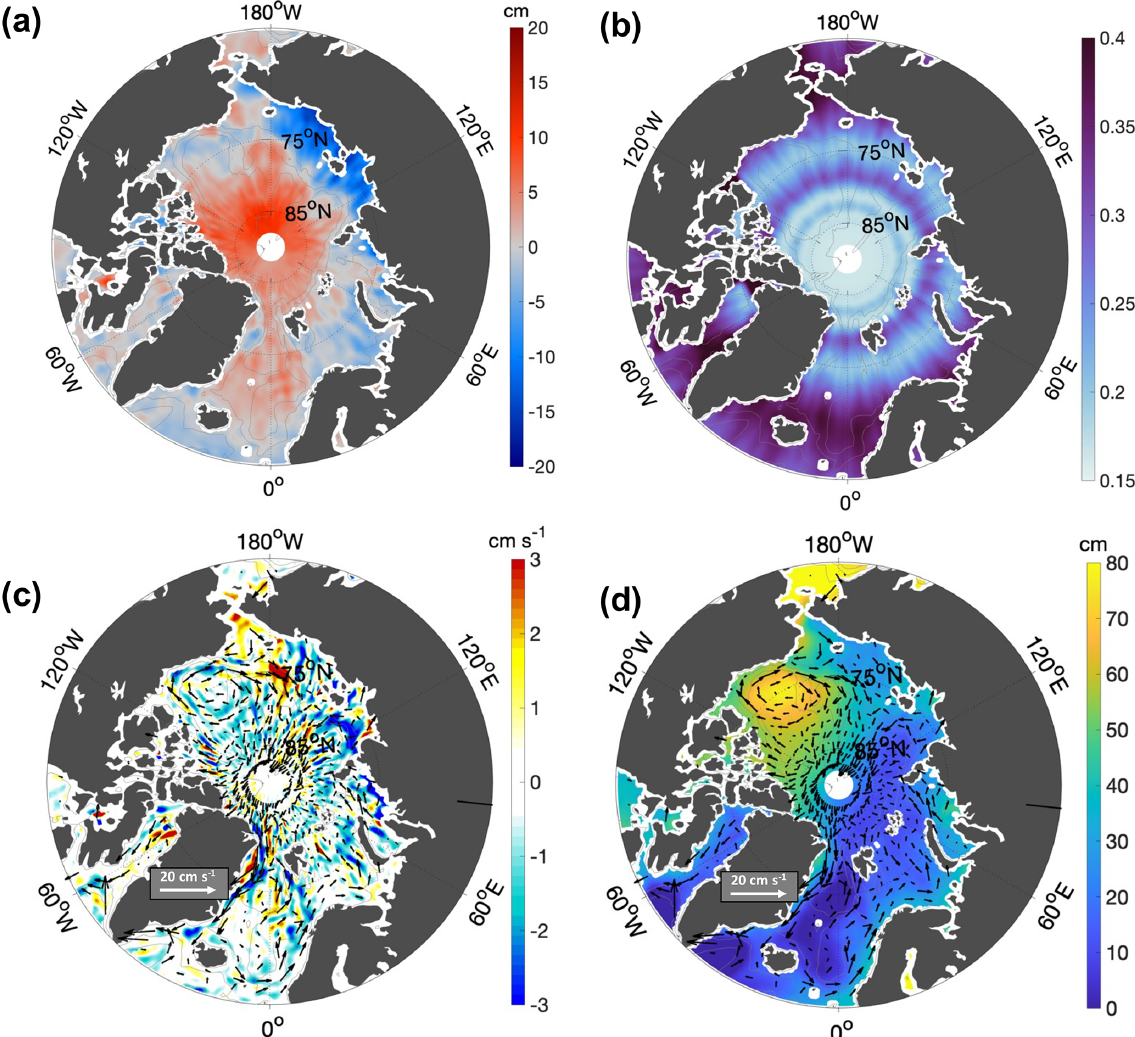
Figure 6. Example of monthly gridded fields included in the final data product for the month of July 2015. (a) The η (cid:48) field above the 2011– 2020 background field. (b) Relative error field on the interpolated η (cid:48) , given as a fraction of the variance of the background field. (c) ( u g ,v g ) field. Arrows in panel (c) represent the absolute ( u g ,v g ) field for the month of July 2015, whereas color highlights the anomaly of the monthly (cid:113) u 2 g + v 2 g ) with respect to the mean geostrophic speed over the period 2011–2020. (d) Dynamic ocean topography geostrophic speed ( V g = ( η , background color) and the associated geostrophic velocity field (as in panel c ). Bathymetry contours are drawn at 100, 1000 and 2500m